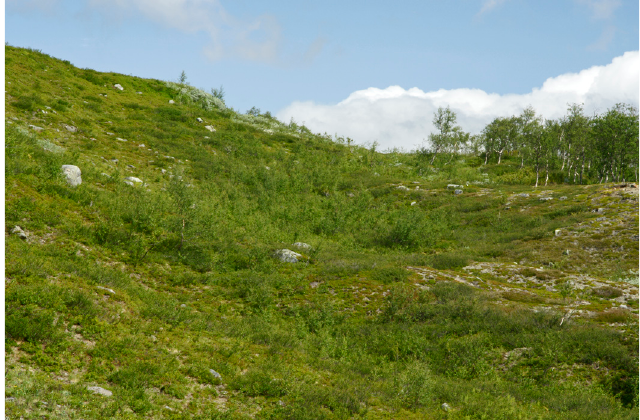
Figure 17: “Embryonic” birch wood rapidly forming in a depression, where late-laying snow precluded tree growth until the mid-2000s. Intensive reindeer grazing and tramp- ling at this site has not prevented birch establishment. Mt. Getryggen, 795 m a.s.l. 17 July,